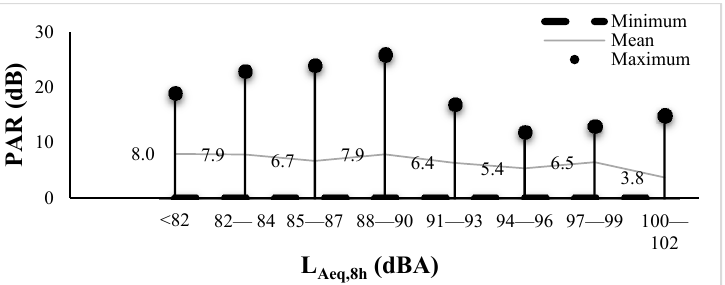
Figure 3. PAR ranges by L Aeq,8h group of noise-exposed workers ( n = 385). The spot line in this figure represents the mean PAR for each L Aeq,8h group. There is no significant difference in the mean PARs among noise-exposed groups.